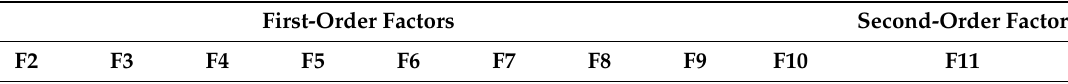
Table 2. Standardized load factors and alpha values for the complete model adapted and analysed.